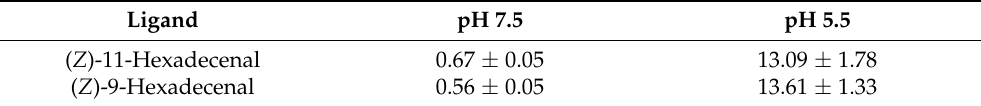
Figure 5. Superimposition of apo-HarmPBP1 at pH 5.5 (limon) on apo-HarmPBP1 at pH 7.5 (cyan). The side chain of His96 in the α 3 α 4 loop changed greatly due to the protonation. The α 3 α 4 loop and the α 5 α 6 loop of the HarmPBP1 at pH 5.5 moved outward so that the pocket formed a larger opening. Z9-16:Ald (green) was docked from the HarmPBP1/Z9-16:Ald complex after superimposition. Table 2. Binding affinities ( µ M) of two major sex pheromones to HarmPBP1 at pH 7.5 and pH